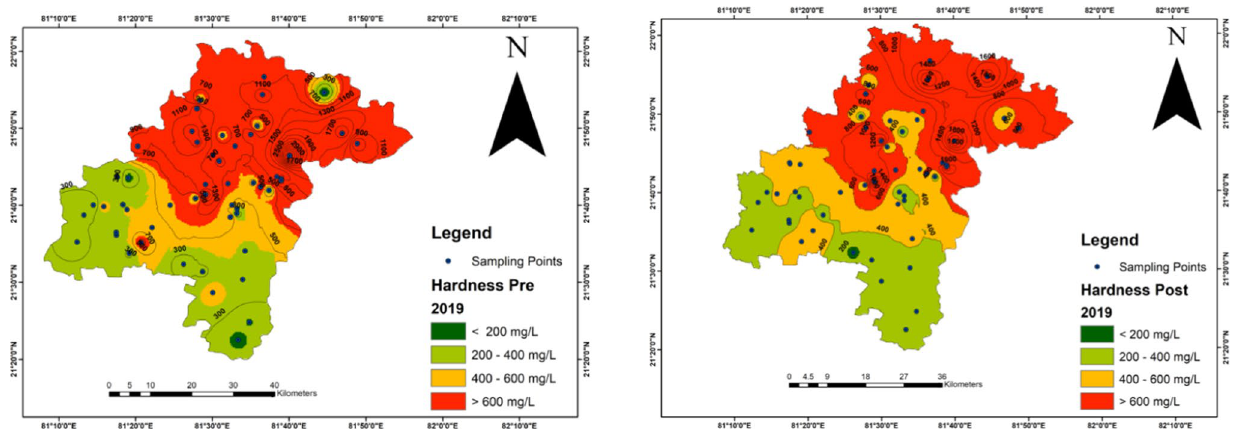
Fig. 6 Spatial distribution of hardness in the groundwater of the study area (pre- and post-monsoon